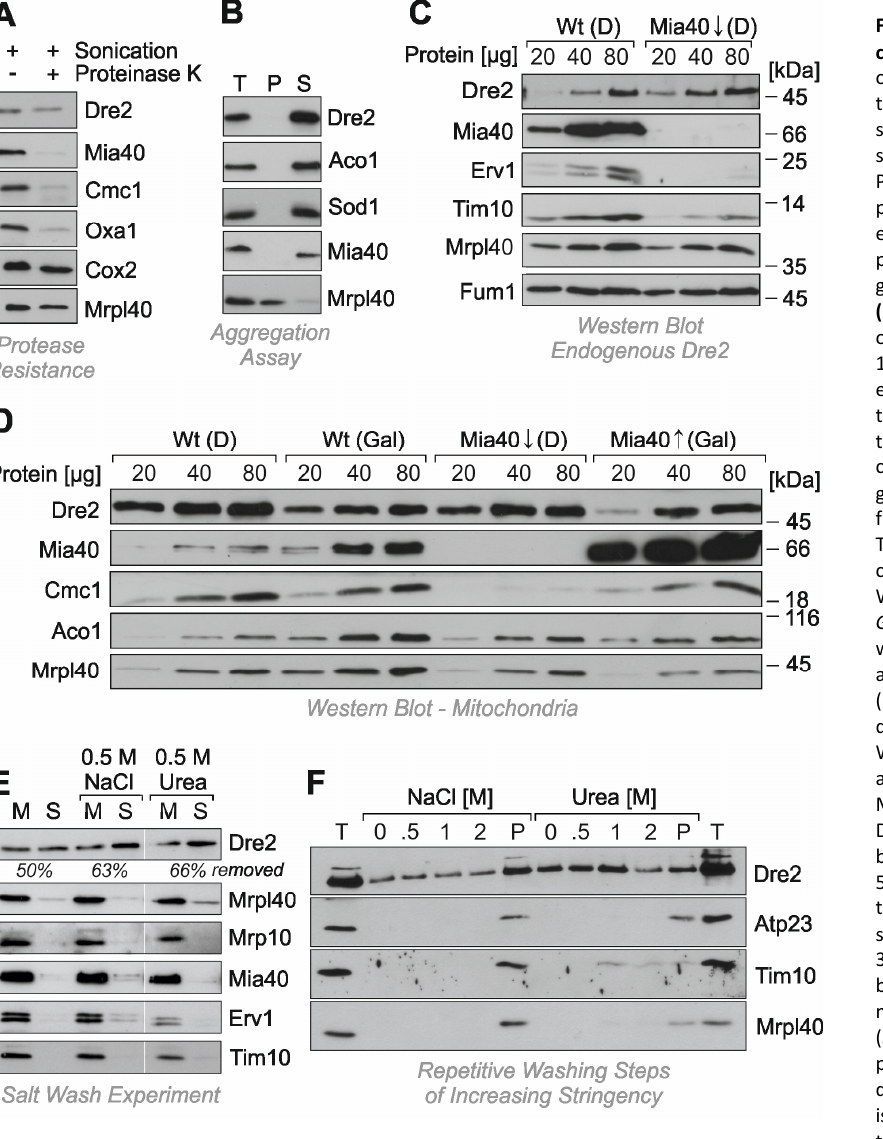
FIGURE 2: Dre2 is not in but on mito- chondria. (A) Mitochondria of Dre2- overexpressing cells were sonicated in the presence of 50 µg/ml proteinase K so that only intrinsically protease- stable proteins remain undigested. Proteins were collected by TCA- precipitation and visualized by West- ern blotting. Cox2 and Mrpl40 are protease-resistant due to their inte- gration into large protein complexes. (B) Mitochondria of Dre2- overexpressing cells were lysed with 1% Triton X-100. The extract was either directly loaded to the gel (T, total) or after separation of superna- tant (S) and pellet (P) fractions by centrifugation for 30 min at 140,000 x g. (C) Mitochondria were isolated from wild type or GAL-MIA40 cells. The levels of endogenous Dre2 and control proteins were analyzed by Western blotting. (D) Wild type or GAL-MIA40 cells were transformed with a Dre2-overexpression plasmid and grown in glucose (D) or galactose (Gal) containing medium. Mitochon- dria were isolated and subjected to Western blotting with antibodies against the depicted proteins. (E) Mitochondria were isolated from a Dre2-overexpressing strain and incu- bated with SEH buffer (0.6 M sorbitol, 5 mM EDTA, 20 mM Hepes pH 7.4) in the absence or presence of 0.5 M sodium chloride or urea for 10 min at 30°C. Mitochondria were reisolated by centrifugation. Proteins from the mitochondrial (M) and supernatant (S) fraction were collected by TCA precipitation. The Dre2 signals were quantified and the proportion of Dre2 is indicated that was removed from the mitochondria in the washing step.